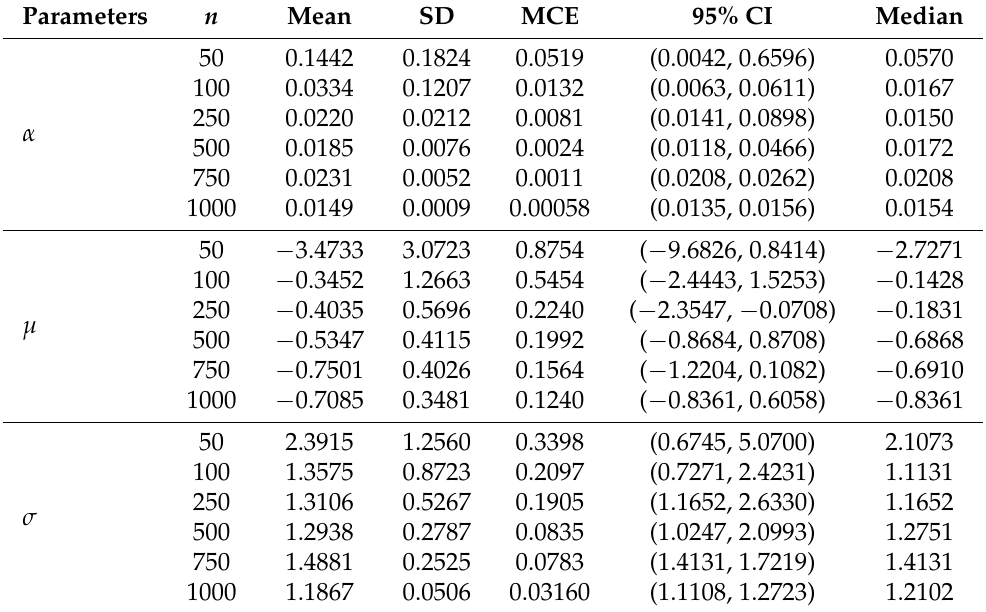
Table 5. Posterior summary results for ( α = 0.01, µ = 0, σ = 1).